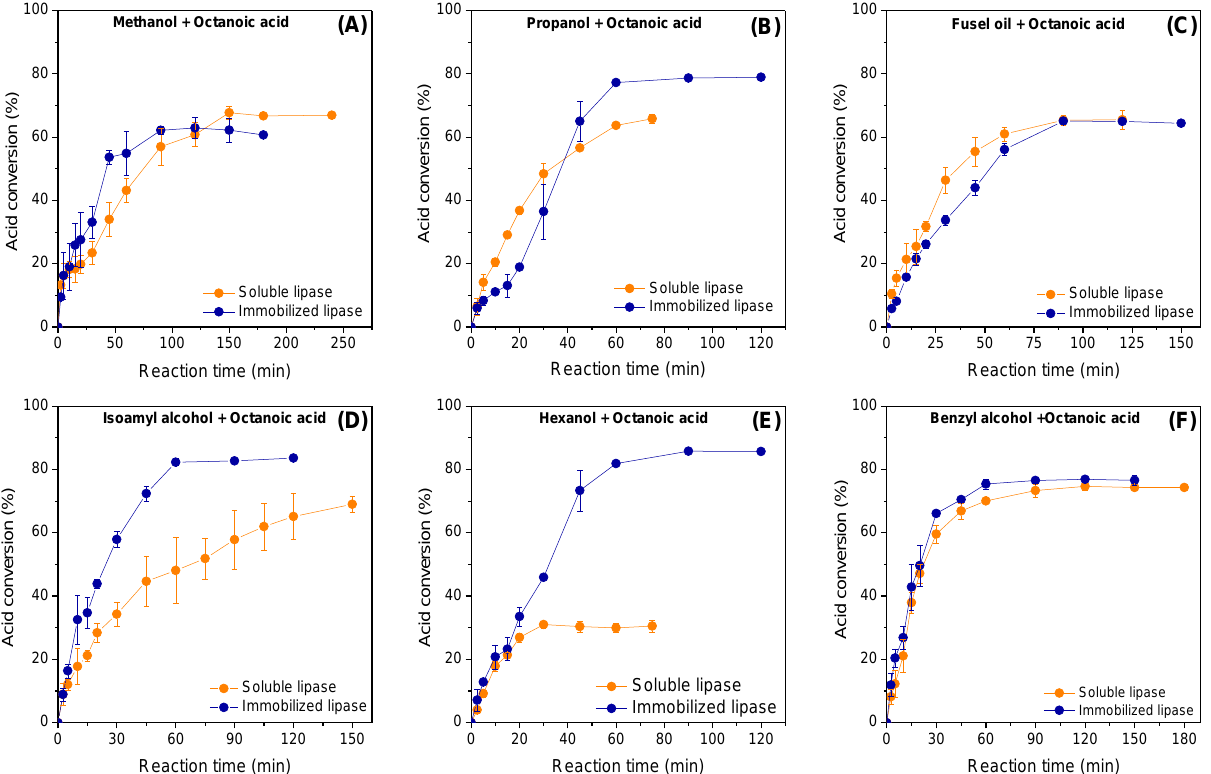
Figure 4. Influence of reaction time on the esterification of ( A ) methanol; ( B ) propanol; ( C ) fusel oil; ( D ) isoamyl alcohol; ( E ) hexanol; and ( F ) benzyl alcohol with octanoic acid catalyzed by soluble and immobilized lipase Eversa ® Transform 2.0. The reactions were performed in solvent-free systems at 40 °C, 240 rpm, stoichiometric acid:alcohol molar ratio and initial protein concentration of 3.3 mg protein per gram of reaction mixture.